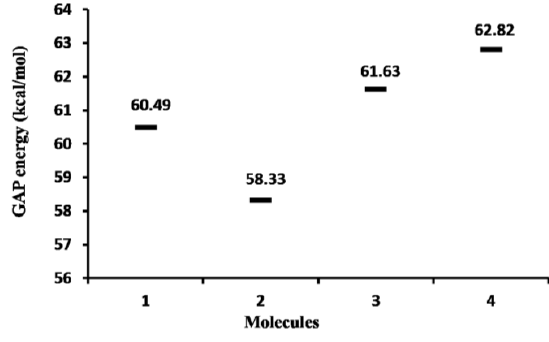
Figure 3: Gap energy plot (kcal/mol) of the target molecules.